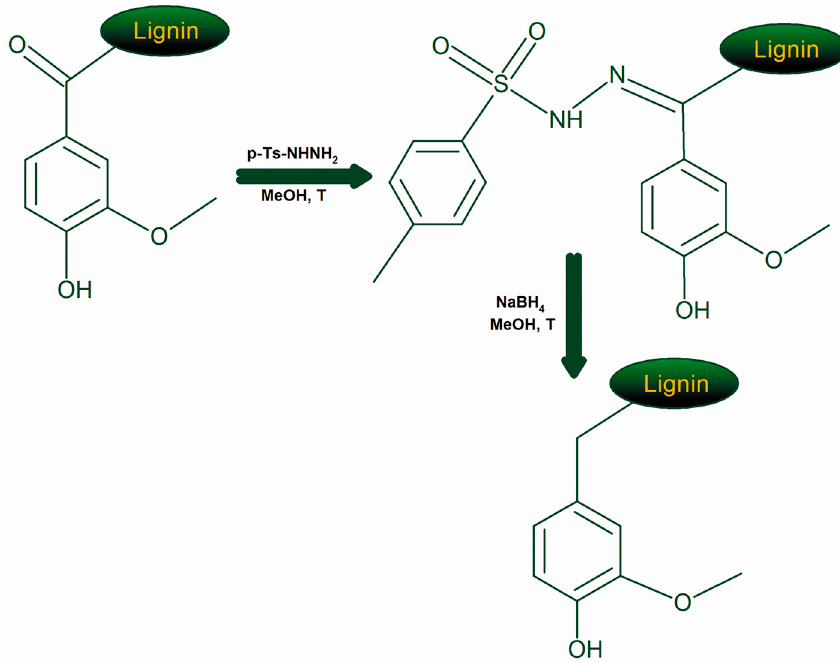
Figure 6. Reaction pathways used for the elimination of lignin carbonyl groups.